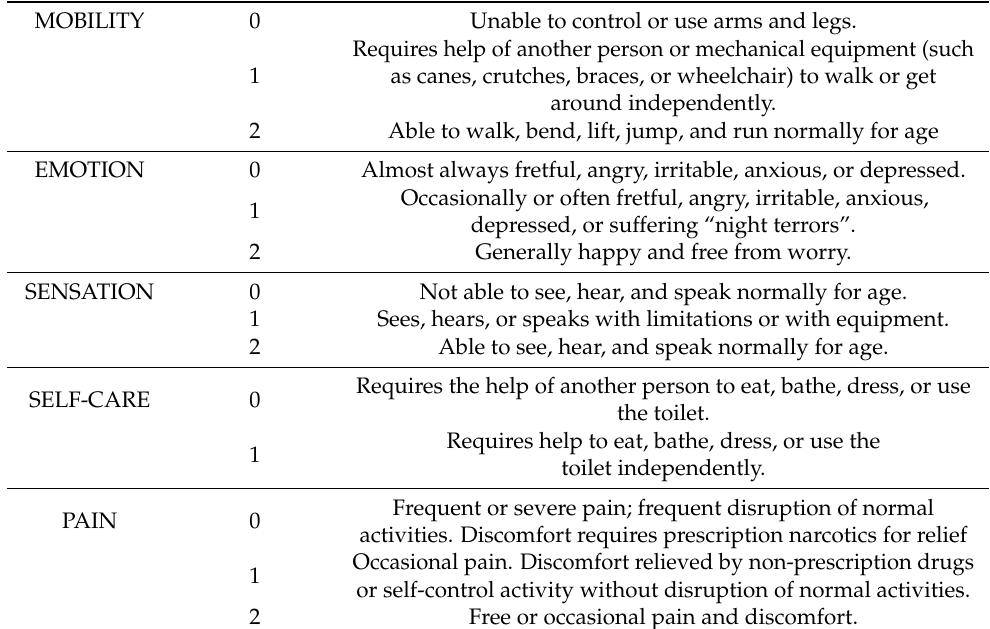
Table A1. Health-related quality of life questionnaire, adapted, abbreviated. MOBILITY